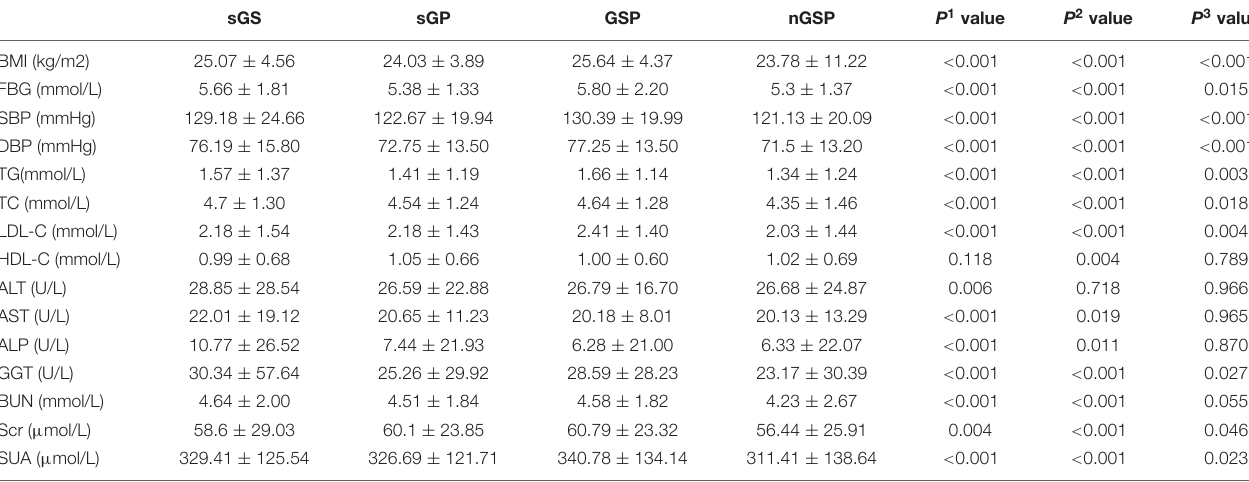
TABLE 2 | Comparison of related factors of gallbladder stones and gallbladder polyps.